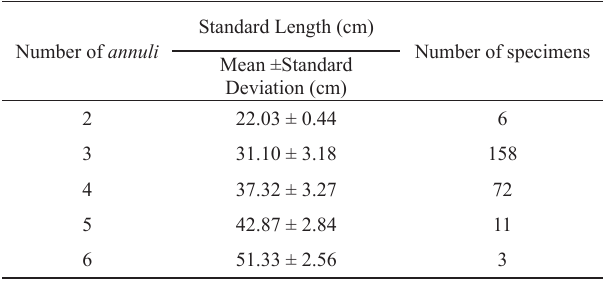
Table 2. Number of annuli , mean standard length and number of Cichla temensis specimens.